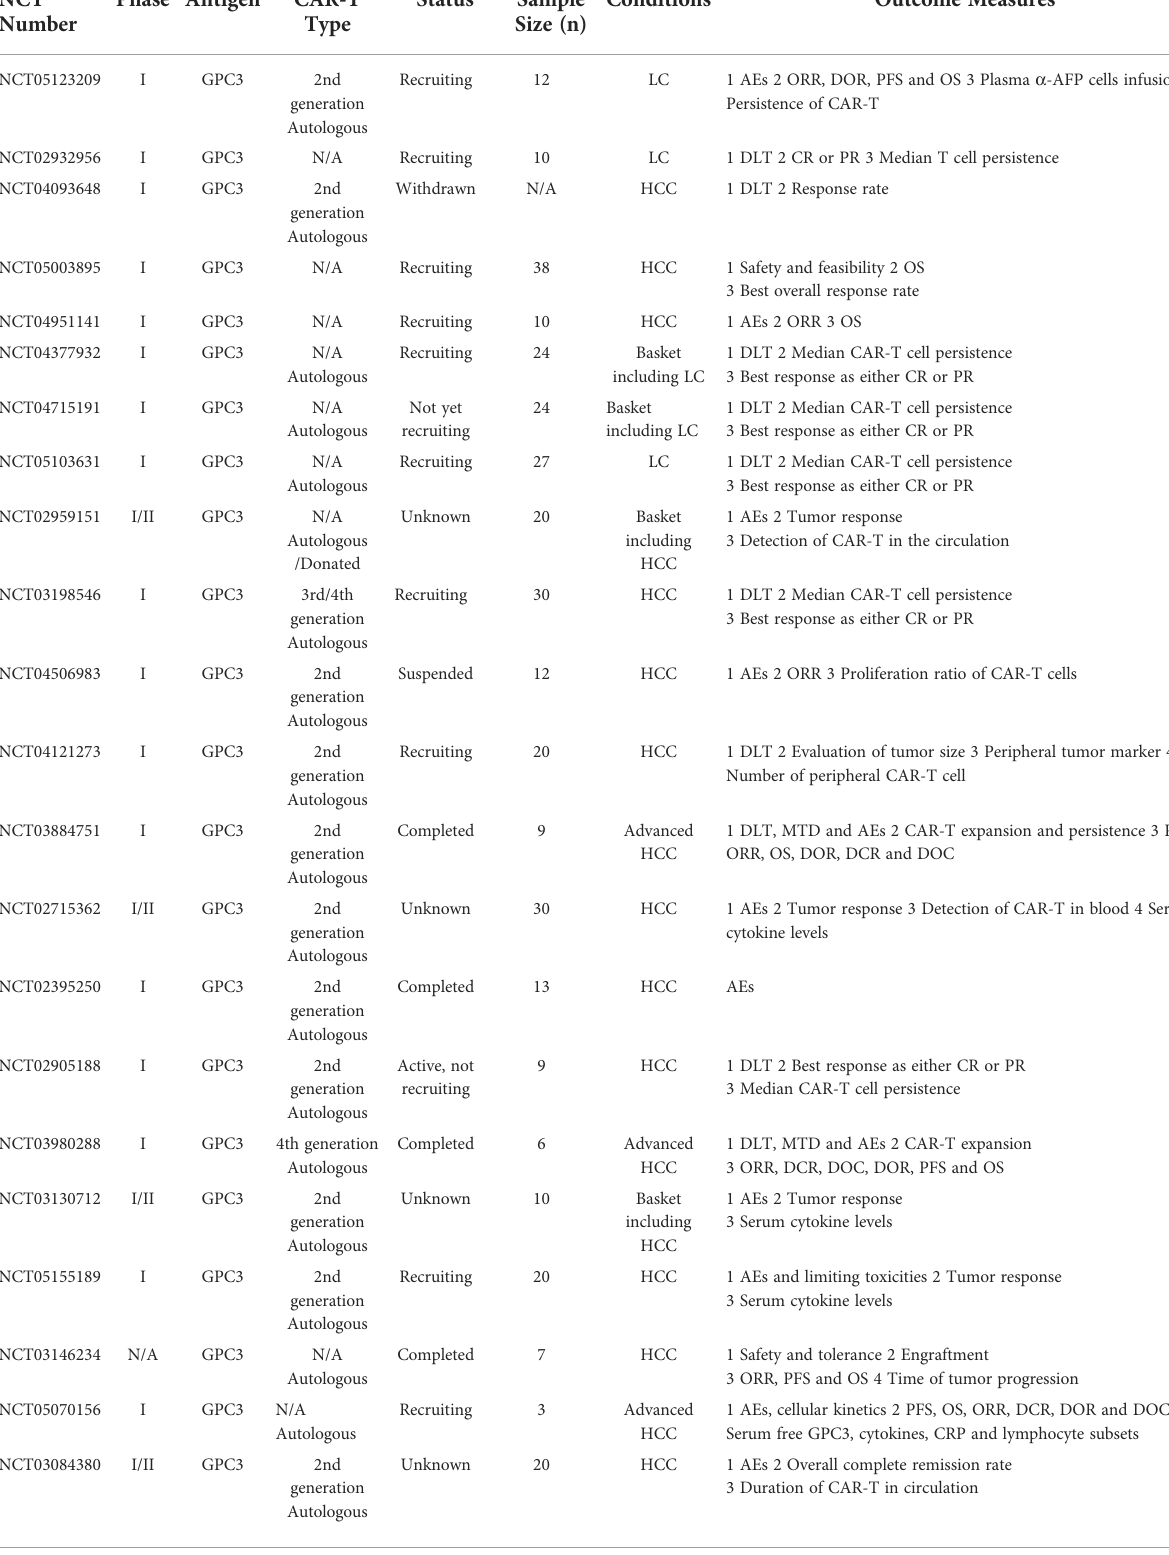
TABLE 1 Clinical trials in HCC using